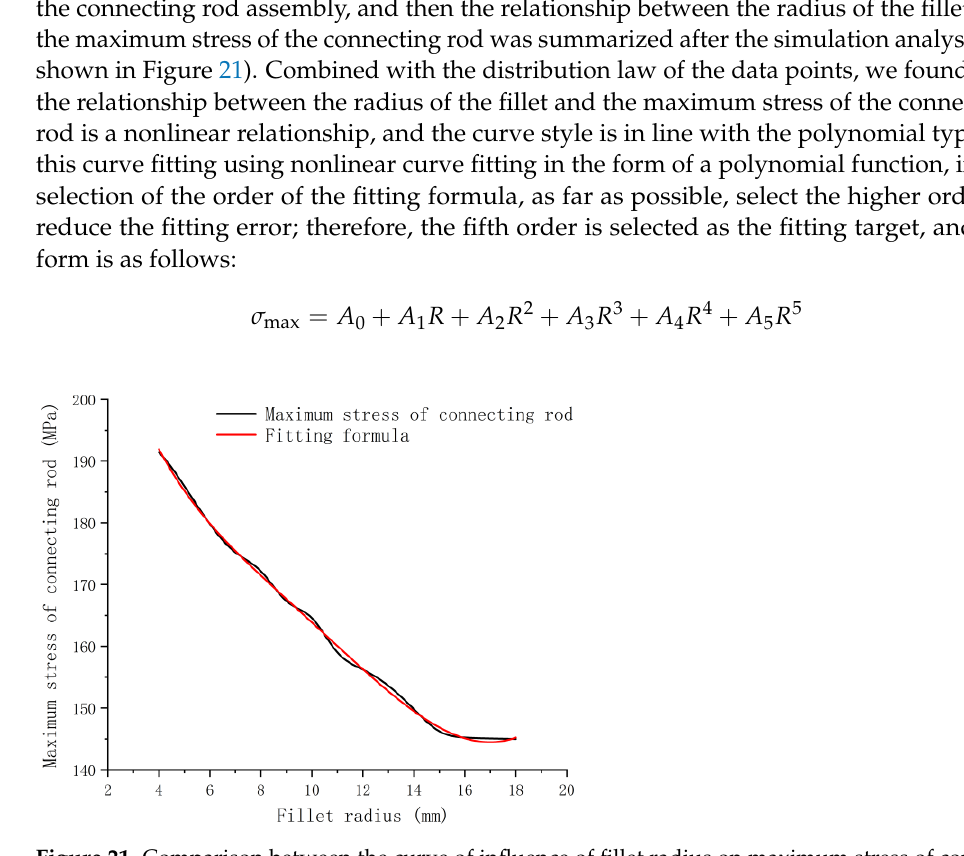
Figure 20. Safety factor diagram of optimized connecting rod body.